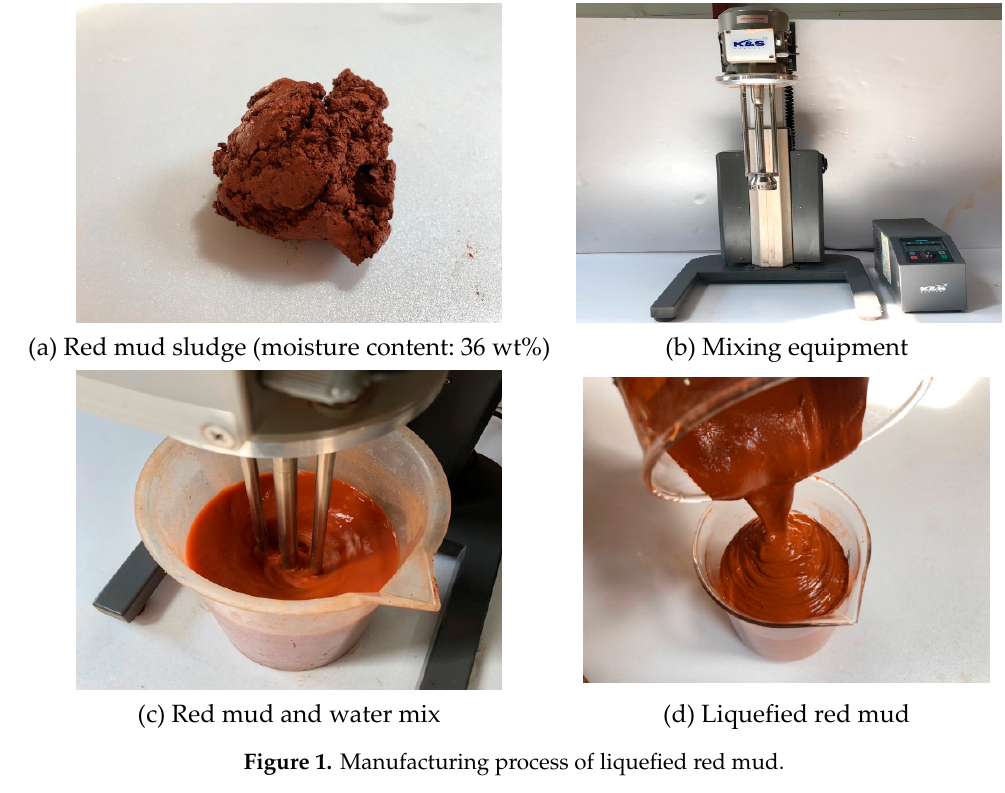
Figure 1. Manufacturing process of liquefied red mud.